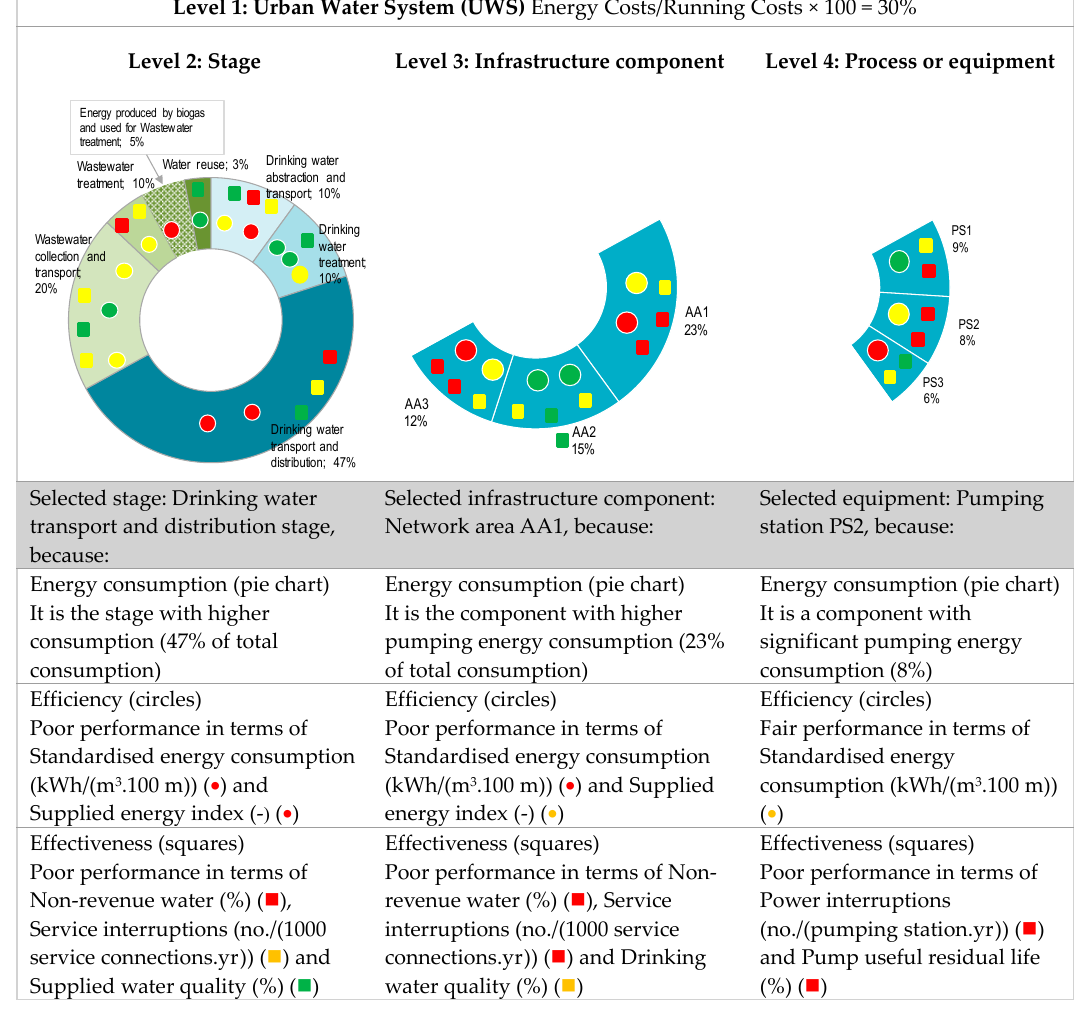
Figure 1. Example of application of the framework at each level of analysis (the pie charts represent the energy consumption, the circles the energy efficiency performance indicators (PIs) and the squares the effectiveness PIs).